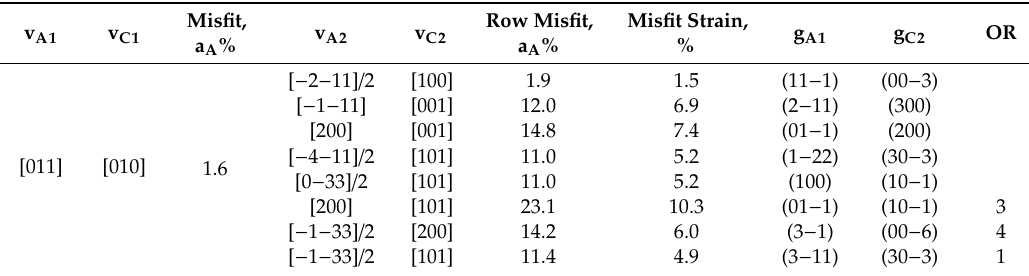
Table 3. Predicted OR with the near atomic row matching method for the austenite and cementite system with the row parallel to [011] A / [010] C